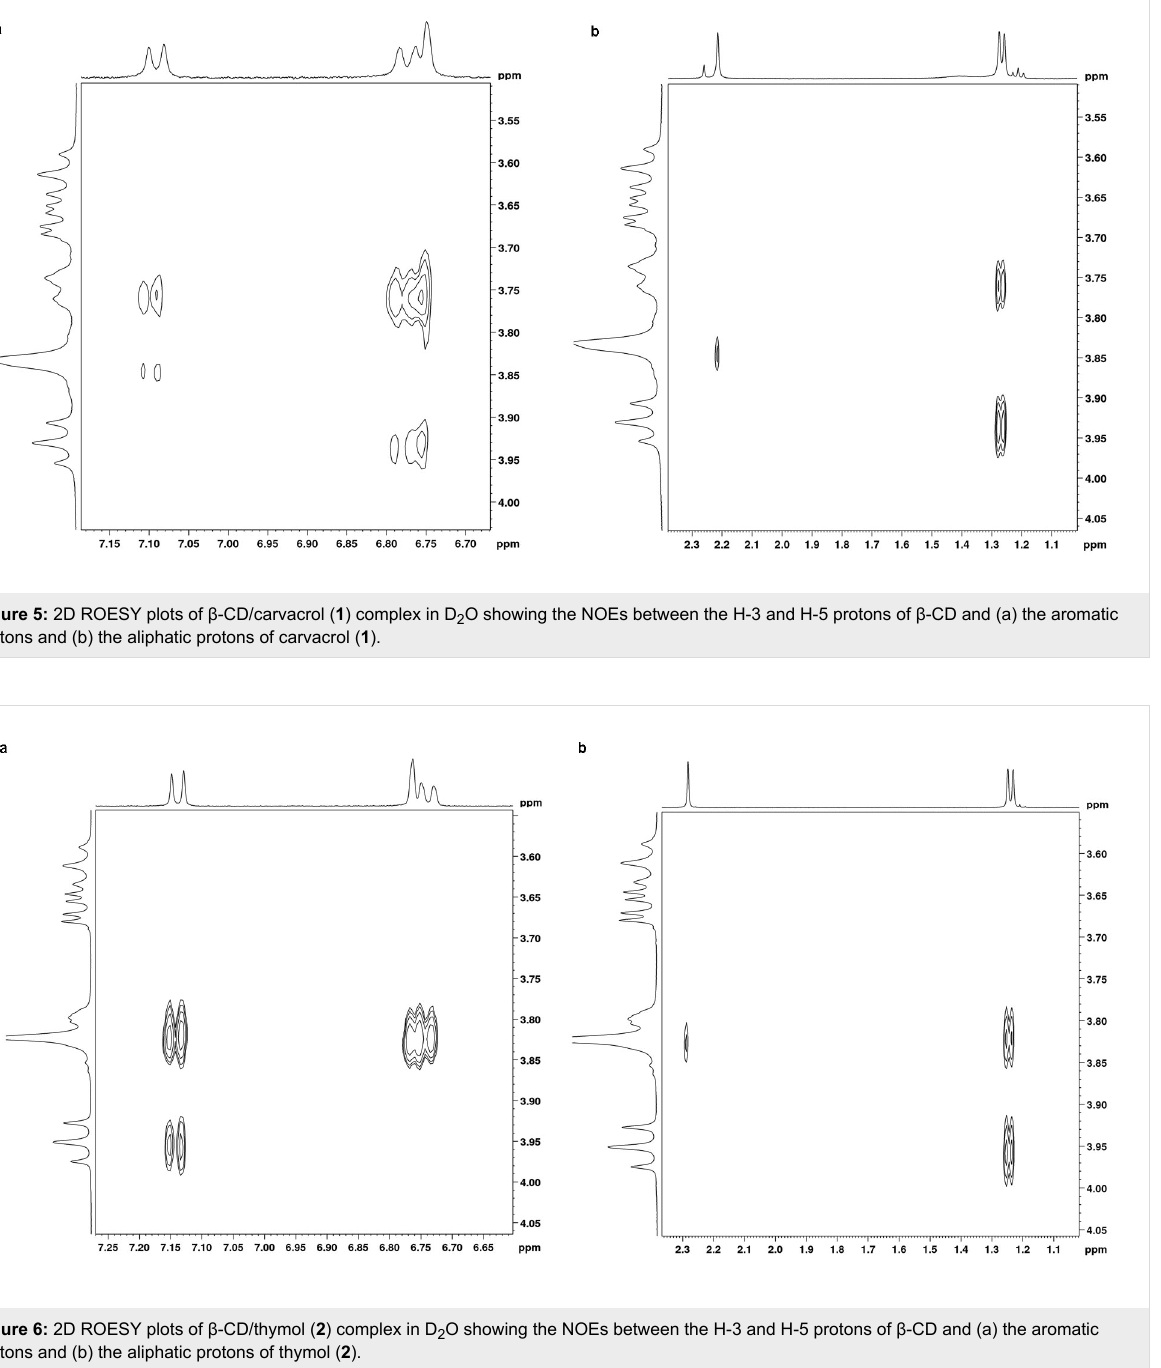
of 1 and H b proton of 2 are oriented toward the narrower prima- ry rim of β -CD. Moreover, non-aromatic (aliphatic) protons of both 1 and 2 also revealed cross correlation peaks with CD protons. NOE cross peaks were observed between the protons of the isopropyl group of the guests and both protons H-3 and H-5. This